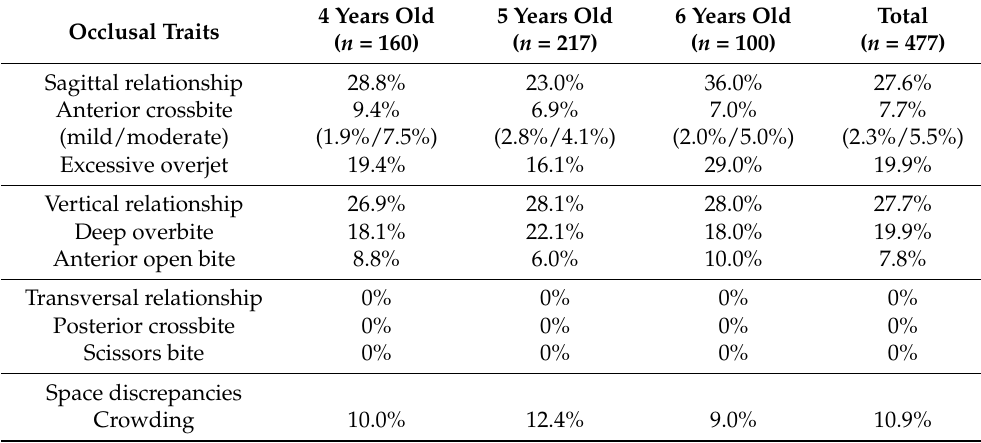
Table 1. Prevalence of each type of malocclusion in Japanese children aged 4–6